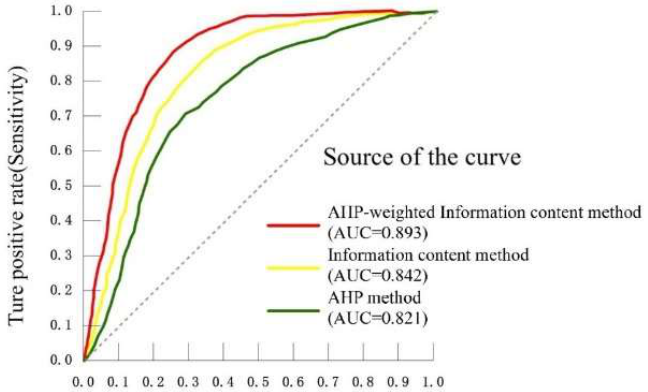
Figure 8. Receiver operating characteristic (ROC)-based comparison of the LS assessment results and analysis of area under curve (AUC) data.